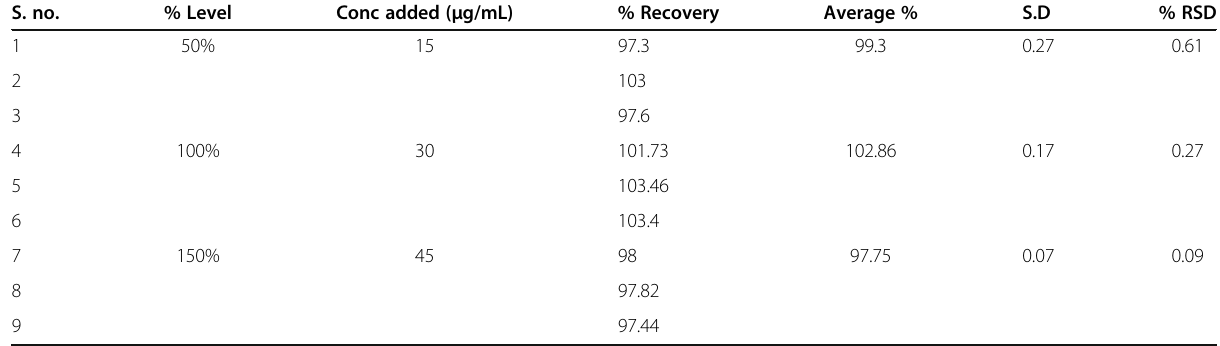
Table 6 % Recovery of Tezacaftor in mobile phase S.